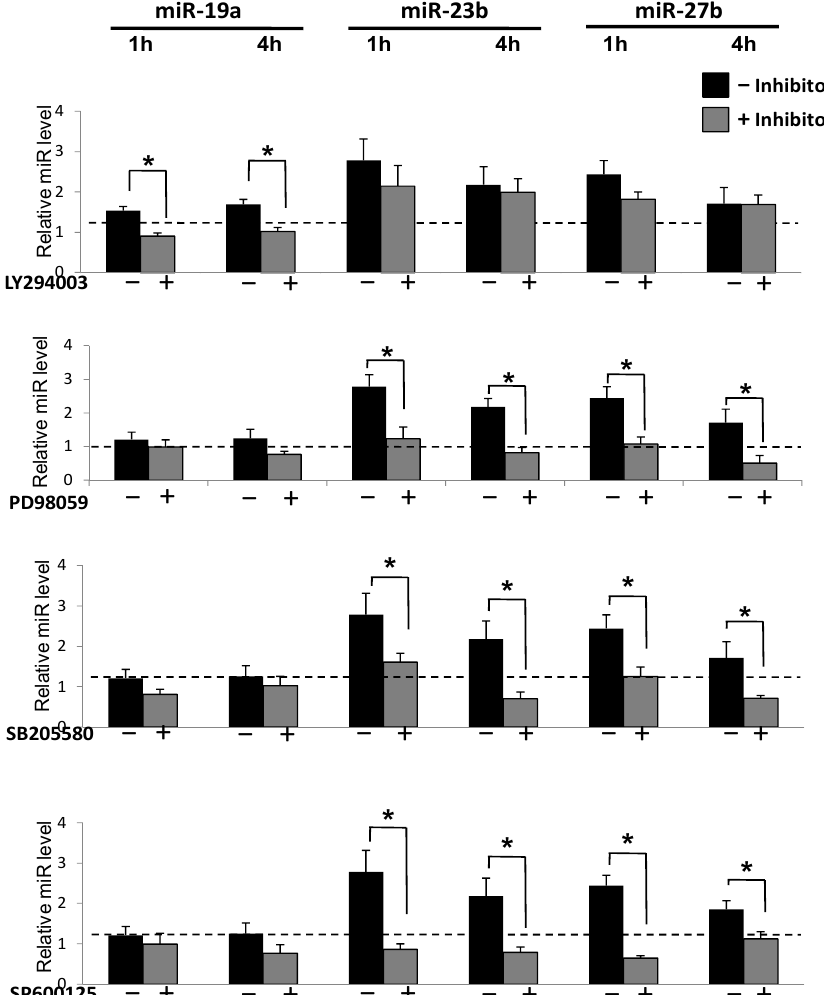
Figure 2. AKT and MAPK in shear-regulation of miRs. 10 µM LY 294002 (PI3K inhibitor), PD 98059 (MAPK inhibitors), SB 203580 (pP38 inhibitor) and SP 600125 (pJNK inhibitor) were used to block the shear-induced phosphorylation of AKT, ERK1/2, p38 and JNK in ECs. 10µM DMSO was employed as control. QRT-PCR shows